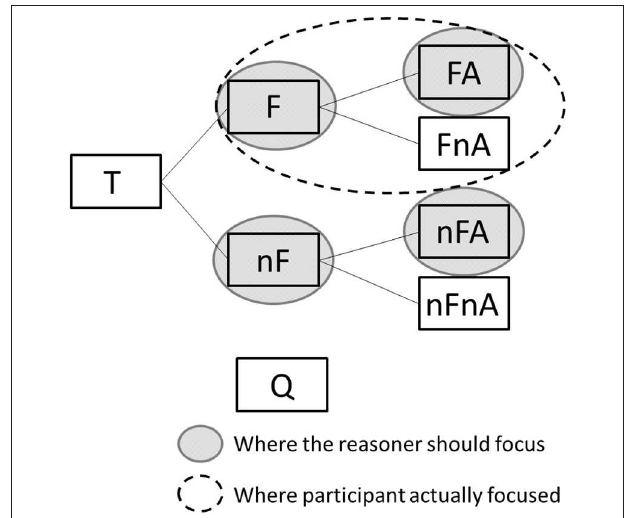
FIGURE 6 | The probability format condition, marked to show where the reasoner should focus (gray-filled ellipses) and where participants actually focused (dashed-line